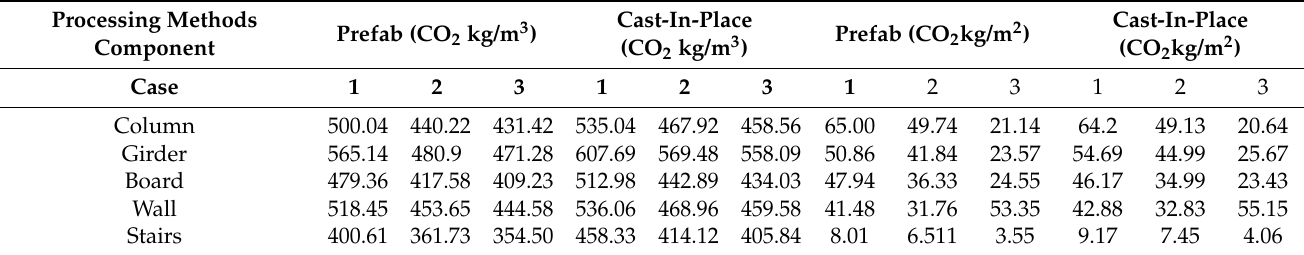
Table 2. Carbon emissions of each component.